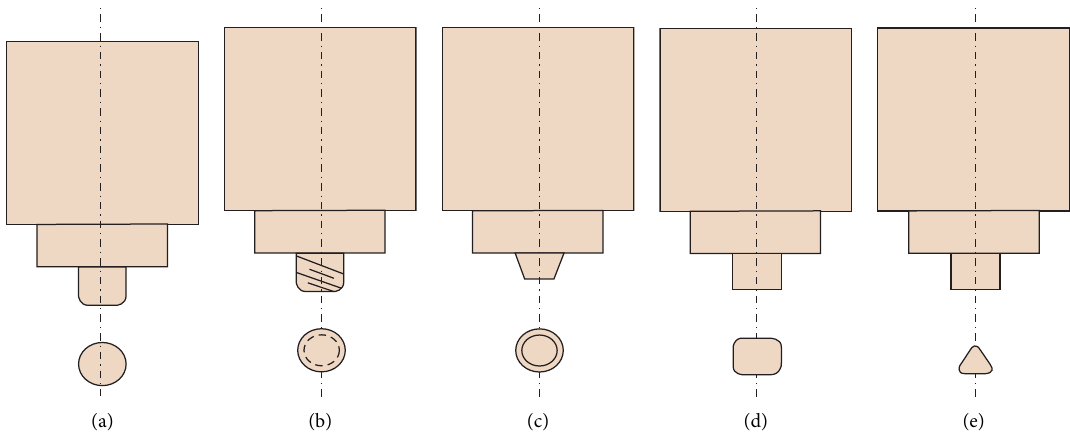
Figure 2: Different tool profiles: (a) straight cylindrical, (b) threaded cylindrical, (c) tapered cylindrical, (d) square, and (e) triangle.